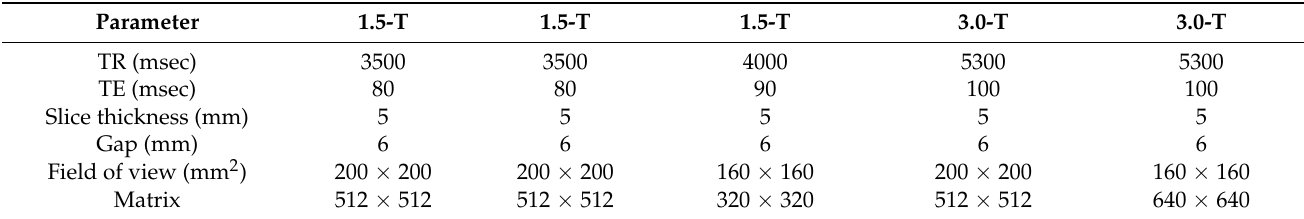
Table 2. MRI scanner types and parameters for axial T2-weighted